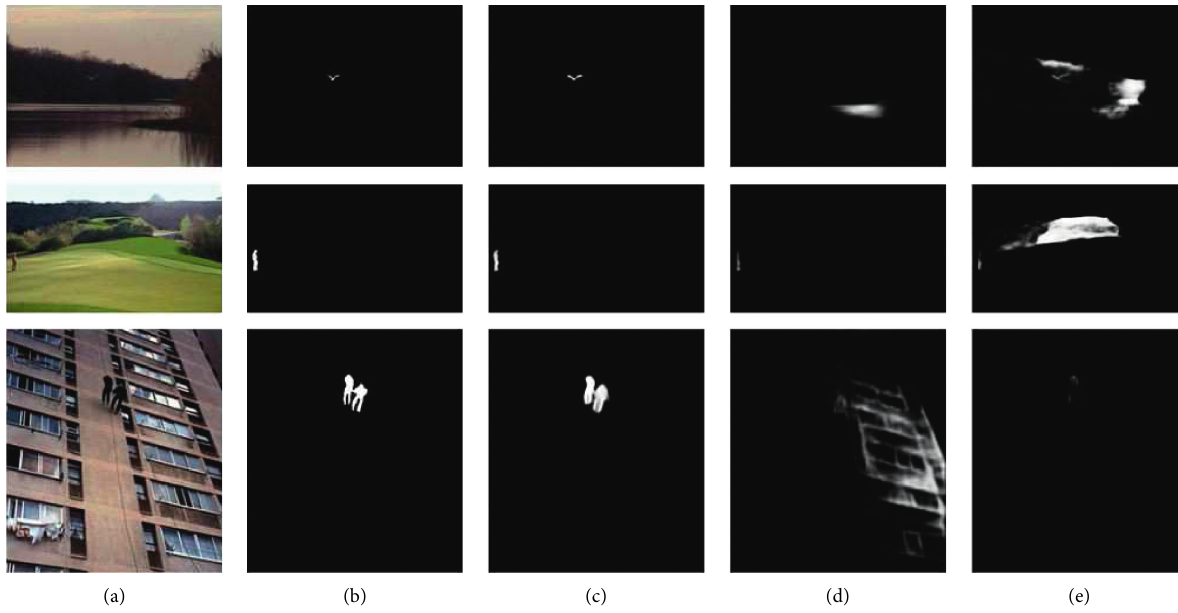
Figure 1: Sample results of our approach (M2Net) compared to GateNet and MINet. (a) and (b) show the input images with small foreground object and the ground truth (GT), respectively. (c), (d), and (e) are saliency maps of ours (M2Net), GateNet, and